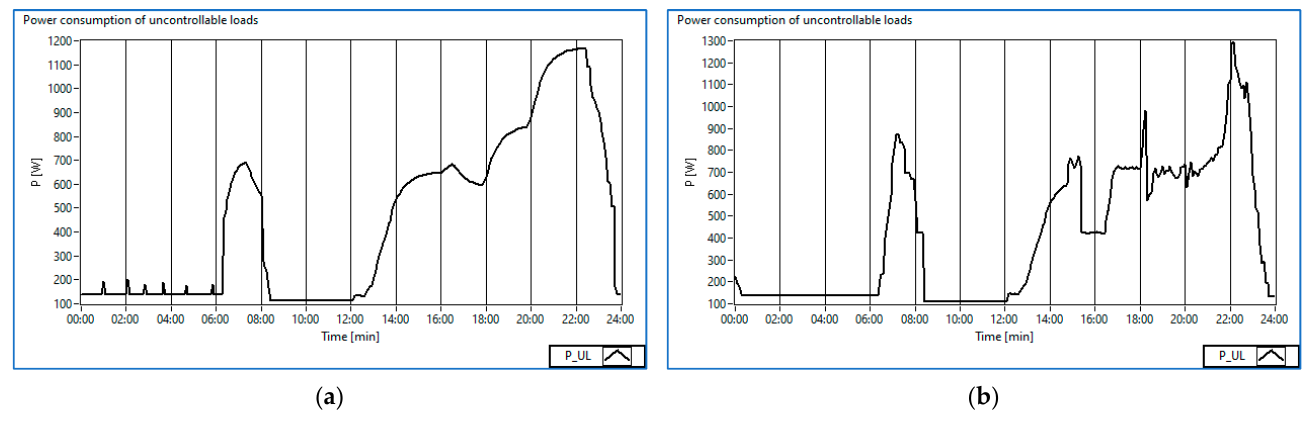
Figure 5. Power consumption (P_UL) for uncontrollable loads: ( a ) scenario 1; ( b ) scenario 2. The considered house has an installed power capacity from photovoltaic-energy sources, of 3.3 kW. The characteristics of the 12 PV panels integrated ino the smart grid, produced by Luxor (ECO LINE P60-275W) are presented in Table 3 The system contains the Huawei SUN2000-3KTL inverter. Table 3. Characteristics of PV panels. Model of PV Panel